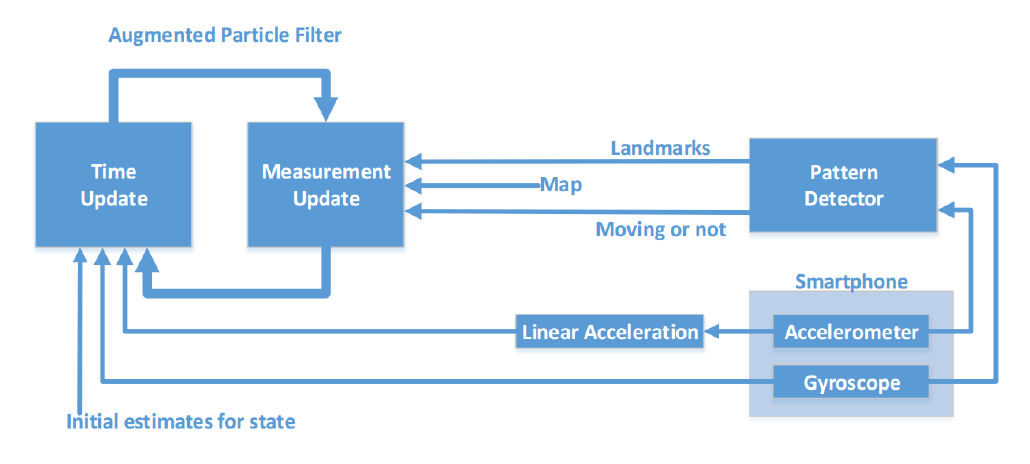
Figure 1. Indoor vehicle localization architecture.